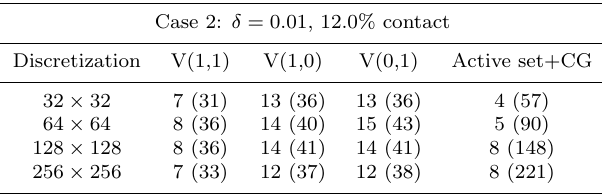
Table 6. Rough contact Case 2: the total number of active set iterations by FMG and the original method, with the numbers of work units in brackets. Case 2: δ = 0 . 01, 12 . 0% contact